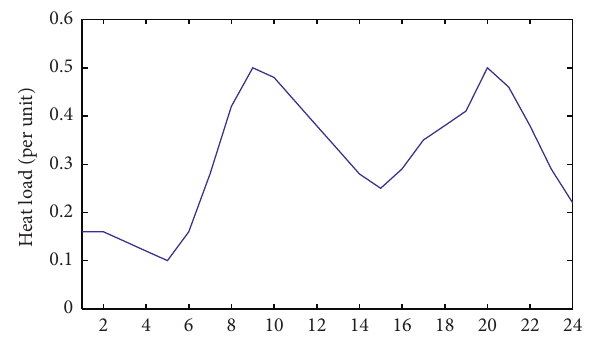
Figure 6: Thermal load data.